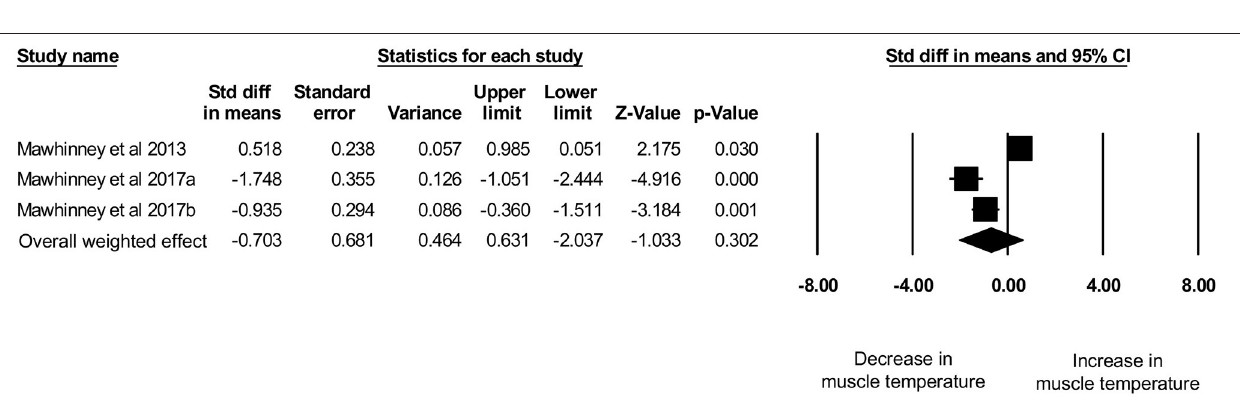
FIGURE 6 | Forest plot of the meta-analysis illustrating the comparison between baseline and post-exercise CWI temperature values at a muscle depth of 2cm.